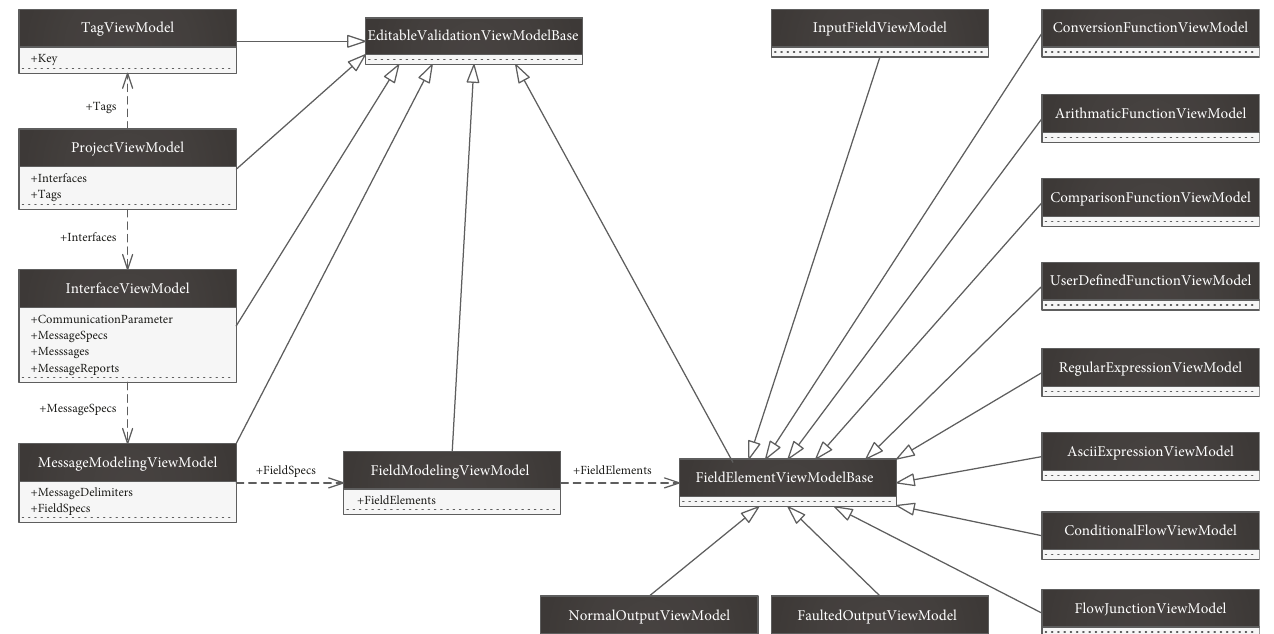
Figure 3: Simpli fi ed class diagram of developed software for fault detection and